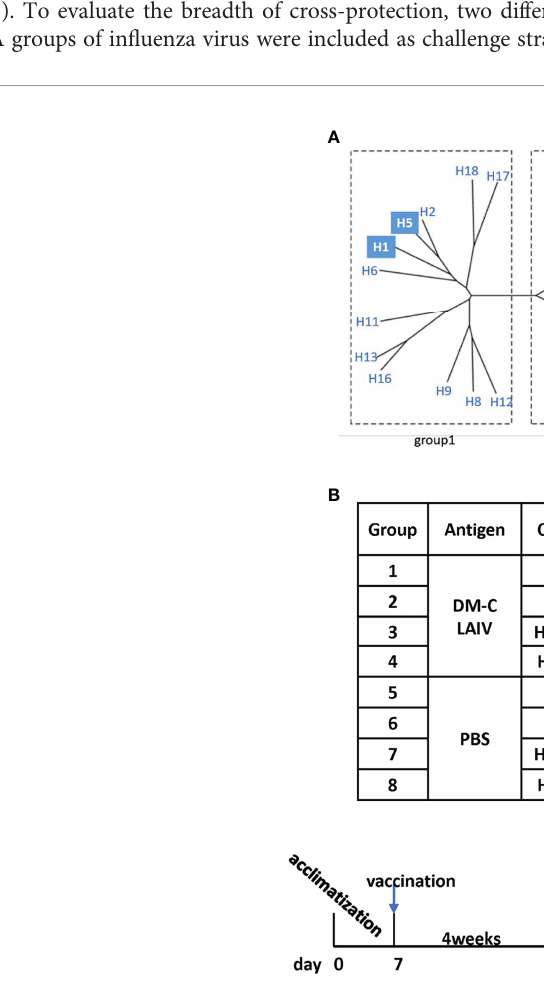
FIGURE 1 | Examining of cross-protection against four types of in fl uenza A viruses in an animal model. (A) Phylogenetic tree of the in fl uenza A virus. In fl uenza A virus has a total of 16 HA subtypes and is divided into groups 1 and 2. As indicated by color boxes, four HA subtypes were used for in vivo experiments and antibody analysis. (B) Schematic diagram of the schedule of immunogenicity and collection of mice sera. Mice sera were collected at 4 and 6 weeks after vaccination and were challenged with four types of in fl uenza A